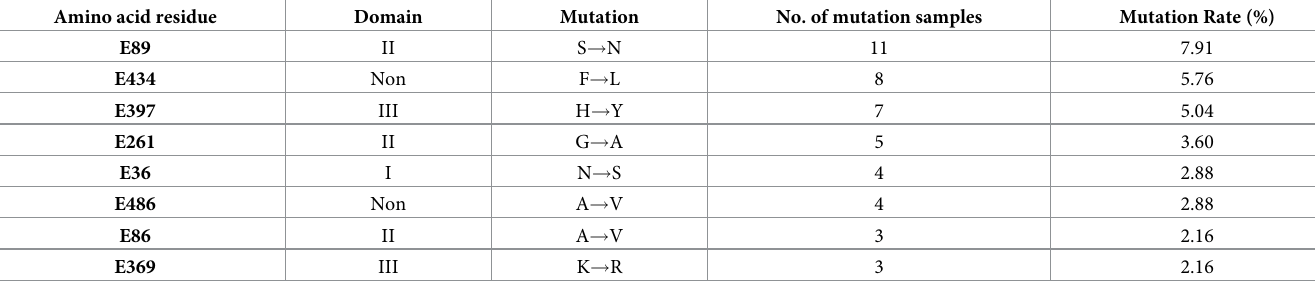
Table 6. Comparison of the amino acid residues of E gene among the 139 JEV-positive sequencing GI samples. Amino acid